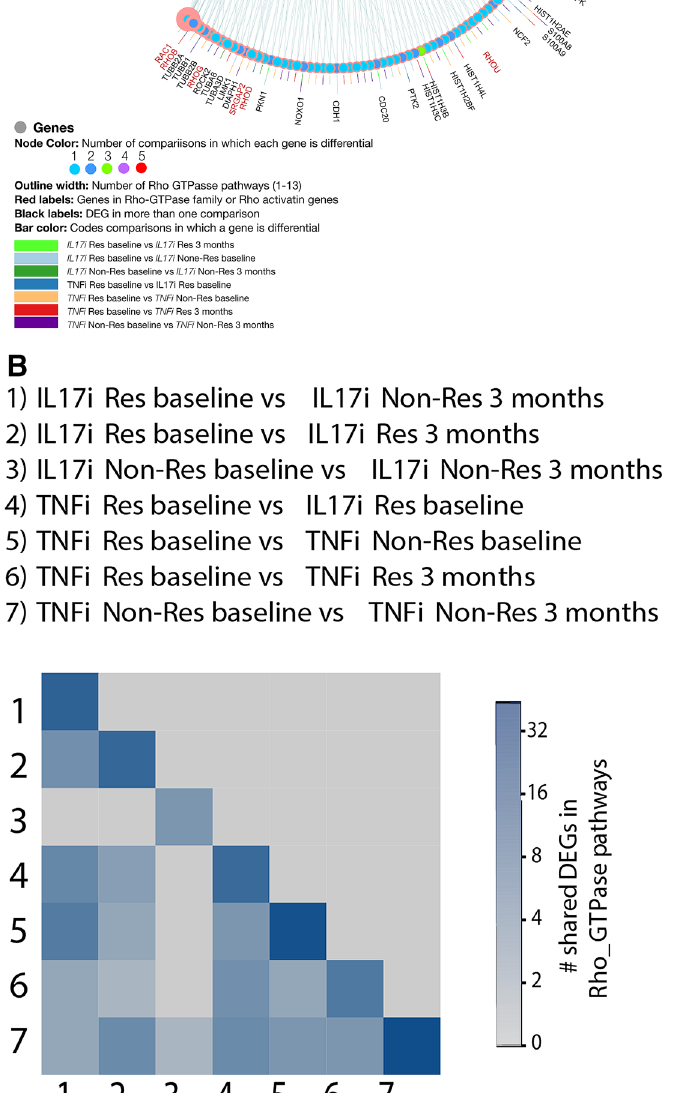
Figure 4. DEGs in Rho-GTPase pathways and their overlap. ( A ) Membership of DEGs in Rho-GTPase pathways. Black labels show DEGs in more than one comparison or members of more than 4 Rho-GTPase pathways. Red labels show DEGs whose protein product is characterized as Rho family GTPase or Rho- GTPase activating protein (based on HGNC annotation). ( B ) Overlap size of Rho-GTPase DEGs in pairs of